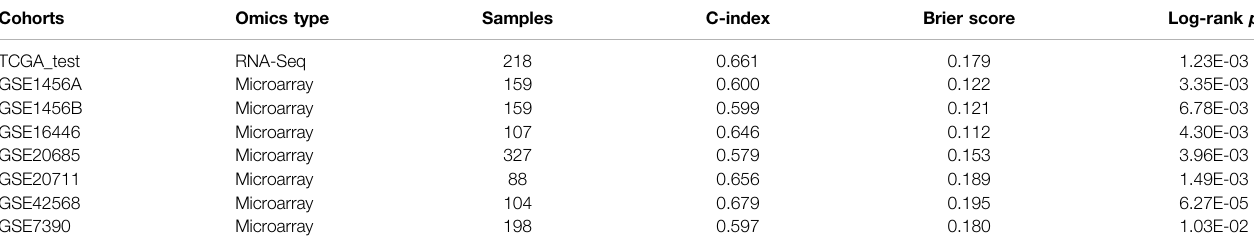
TABLE 1 | Cross-validation based performance robustness of classi fi er on TCGA training and testing